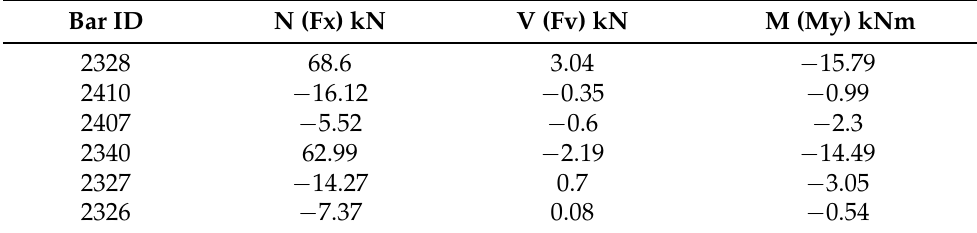
Table 3. The forces at each of the members that are attached to the selected